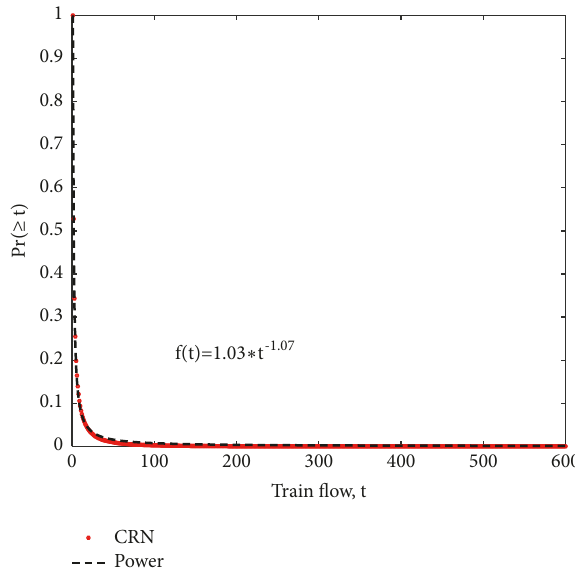
Figure 2: The cumulativedistribution of train flow (edge-weight) in